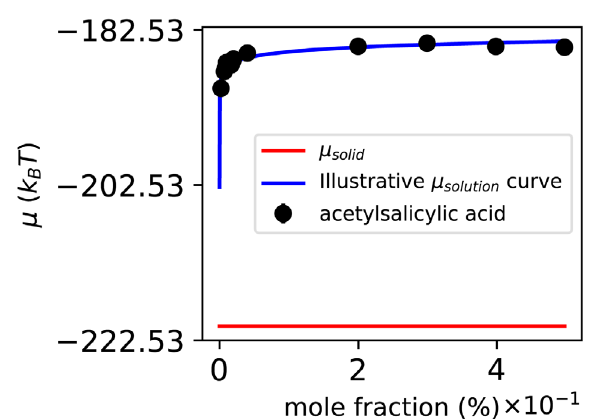
Figure 6. Chemical potentials of ASA, solid and solution in different concentrations, with respect to mole fraction.